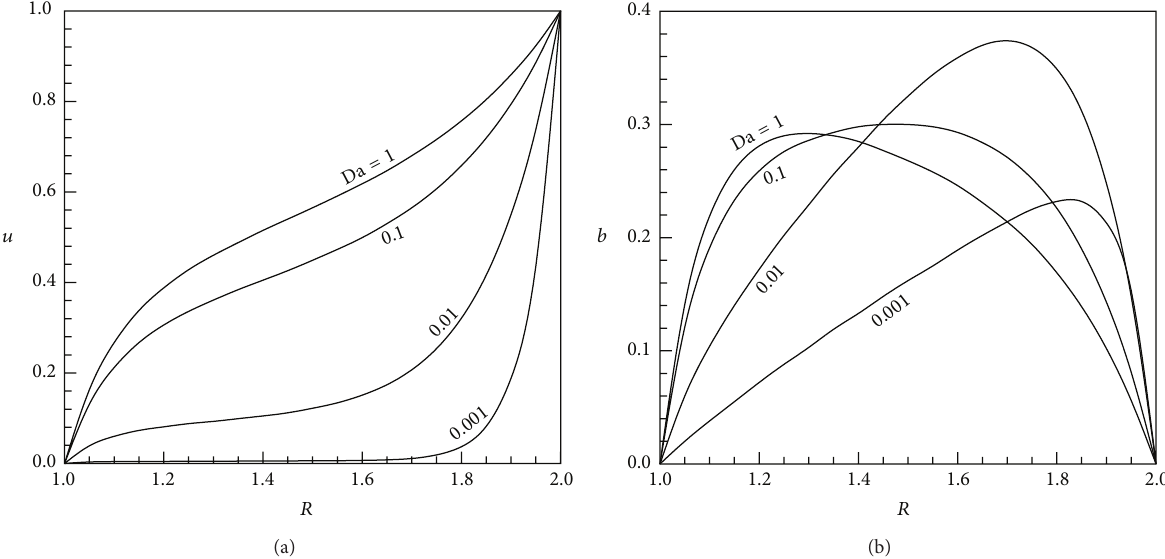
Figure 4: Various profiles for Ha = 10 and different values of Da when both cylinders are insulated: (a) velocity and (b) induced magnetic